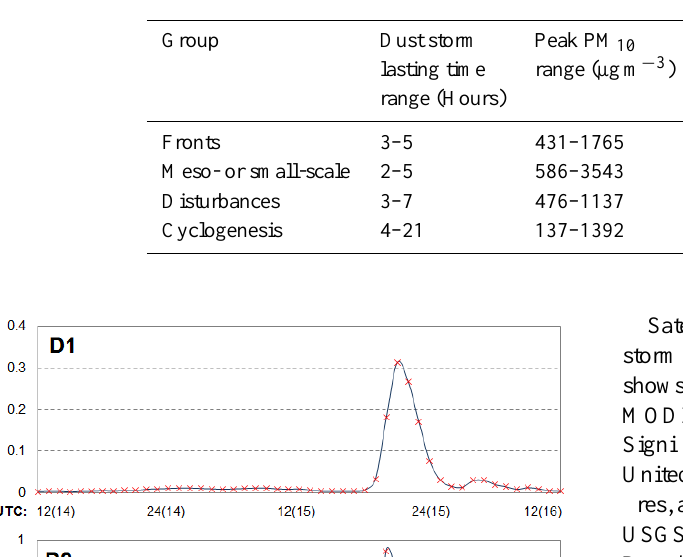
Table 2. Statistical and meteorological properties of peak dust storm processes for each type.